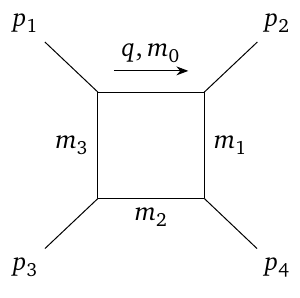
Figure 1: Feynman diagram of the Scalar Passarino-Veltman D